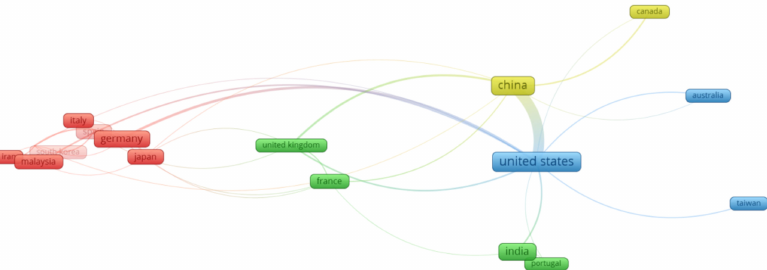
Figure 8. Country visualization of database list “A” obtained by analyzing coauthorship.